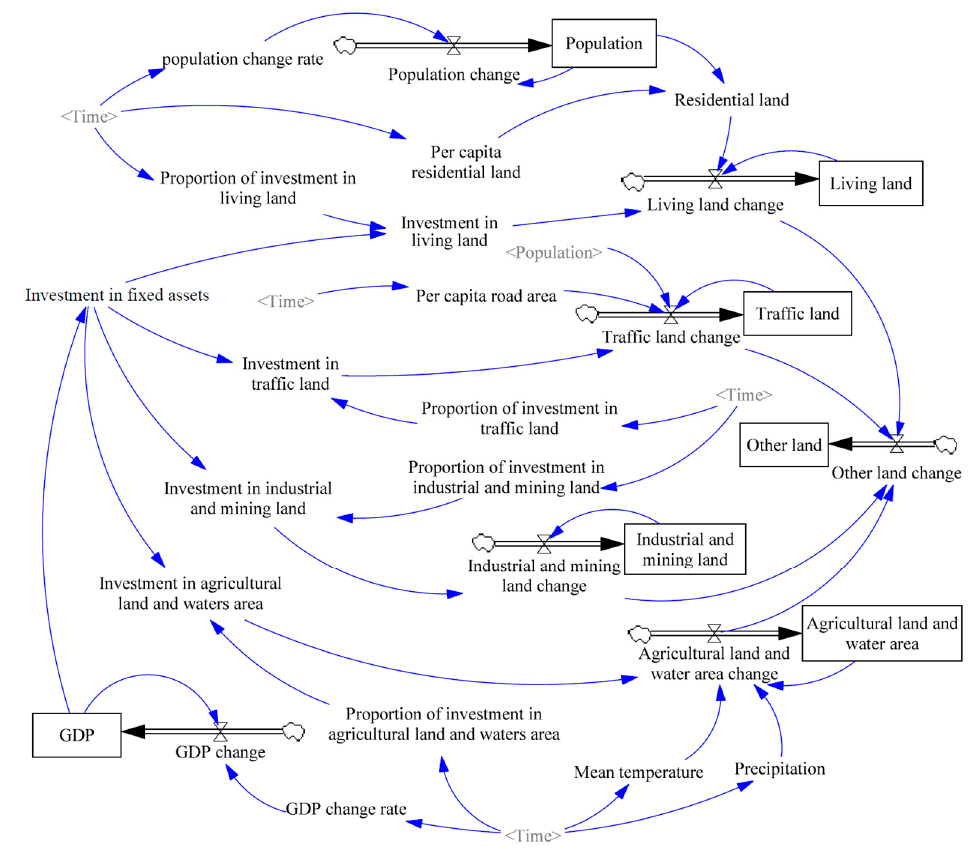
Figure 3. The system dynamics (SD) model of land use demand in Shenzhen.